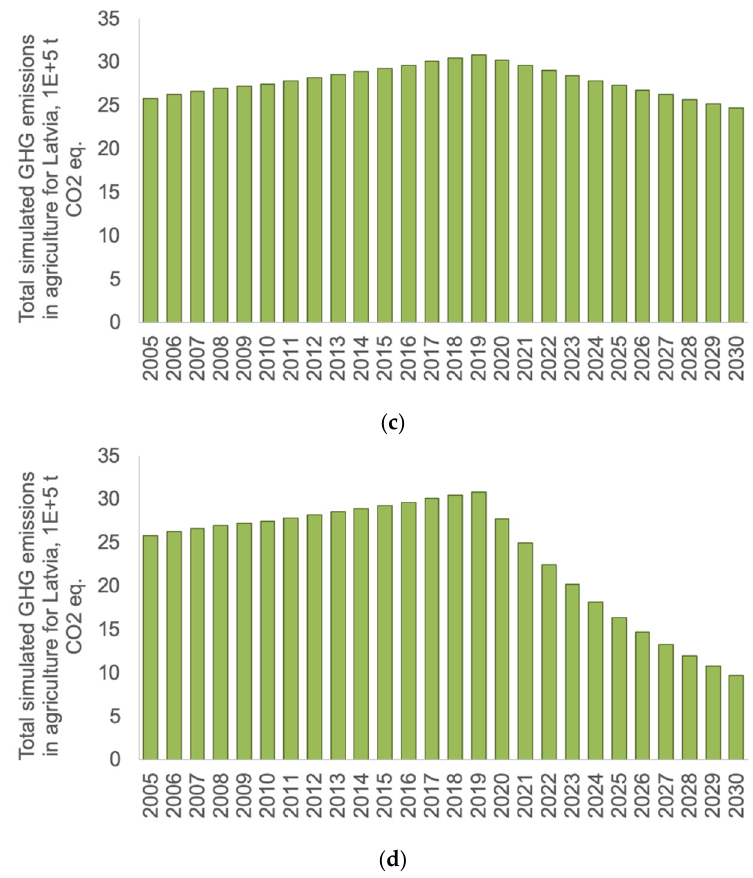
Figure 15. Modelled scenarios for the emissions from agriculture in Latvia, ( a ) reference case or business as usual based on Dace et al. [2], ( b ) constant emission after 2020, ( c ) declining emissions by 2% after 2020, and ( d ) declining emissions by 10% after 2020.